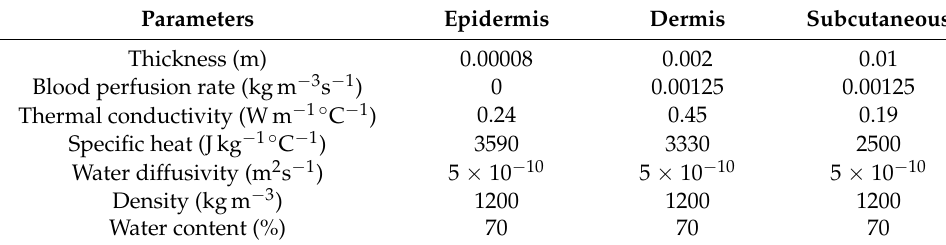
Table 1. Some parameters of multilayer skin tissue used in this paper [30]. Parameters Epidermis Dermis